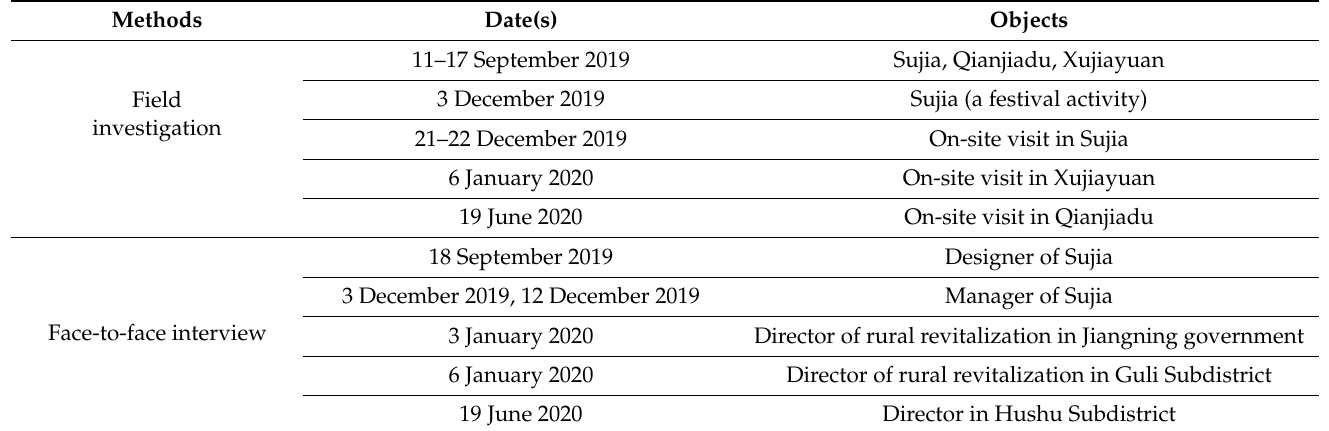
Table 2. Details of the data collection